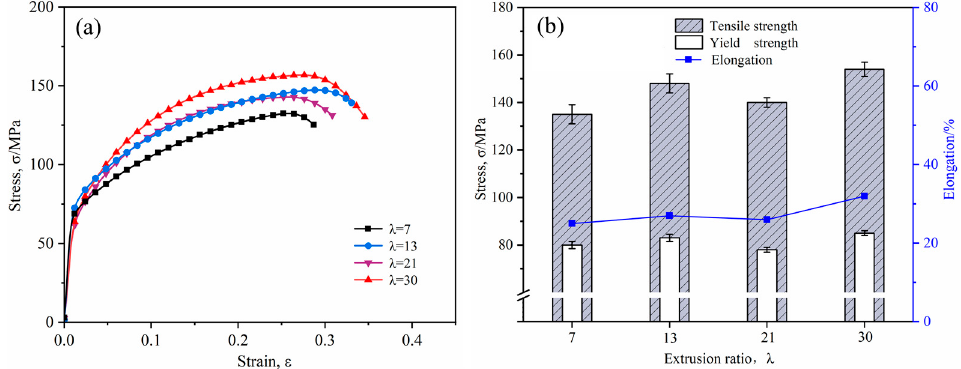
9 of 13 Figure 8. IPF of the extruded alloys: ( a ) λ = 7, ( b ) λ = 13, ( c ) λ = 21, ( d ) λ = 30. 3.4. Tensile Properties The tensile properties of the extruded alloys are shown in Figure 9. In terms of the overall change trend, tensile properties gradually increased with the extrusion ratio in- creasing. Generally, the improvement of mechanical properties is mainly attributed to grain refinement, texture and the second phase [33]. If only the texture is considered, the low texture strength of the alloy at an extrusion ratio of 30 predicts a decrease in its tensile strength. However, the stress-strain curves show that the mechanical properties of the alloy with an extrusion ratio of 30 are better. indicating that the strengthening effect of